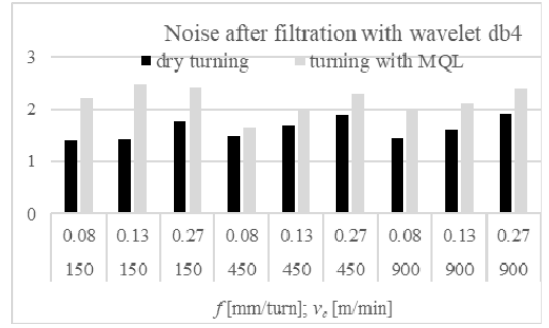
Figure 10. Cutting force Fc in aluminium composite turning with uncoated carbide tool.